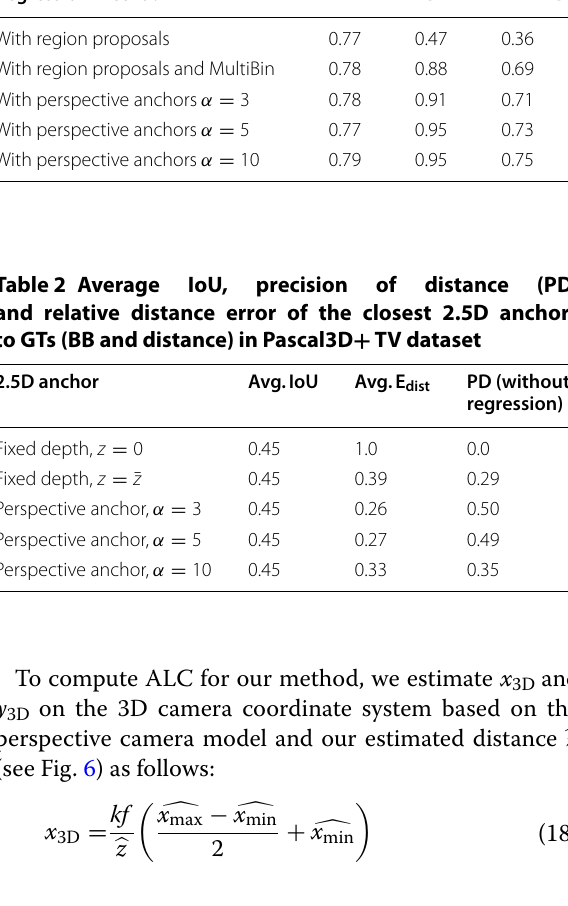
Table 1 Average precision (AP) over foreground thresholds [16], precision of distance (PD) and total average precision (AP × PD) for TV monitor in Pascal3D + Regression method AP PD AP × PD With region proposals